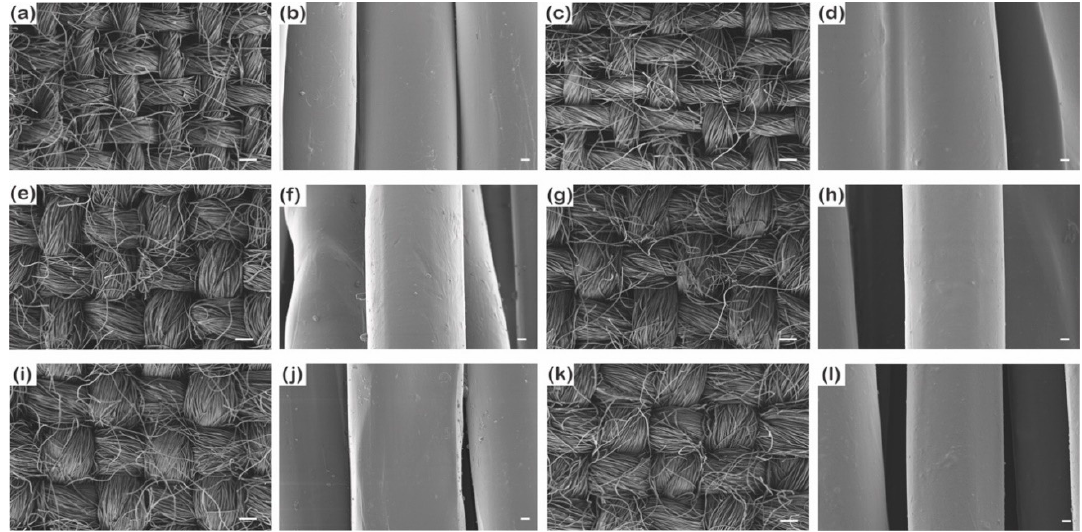
Figure 10. SEM images of untreated 177D ( a , b ), 314D ( e , f ) and 475D ( i , j ) and 1% 4 min PDMS-coated 177D ( c , d ), 314D ( g , h ), and 475D ( k , l ). (magnification: ×100 and scale bar: 200 μ m and magnification: ×10,000 and scale bar: 2 μ m).